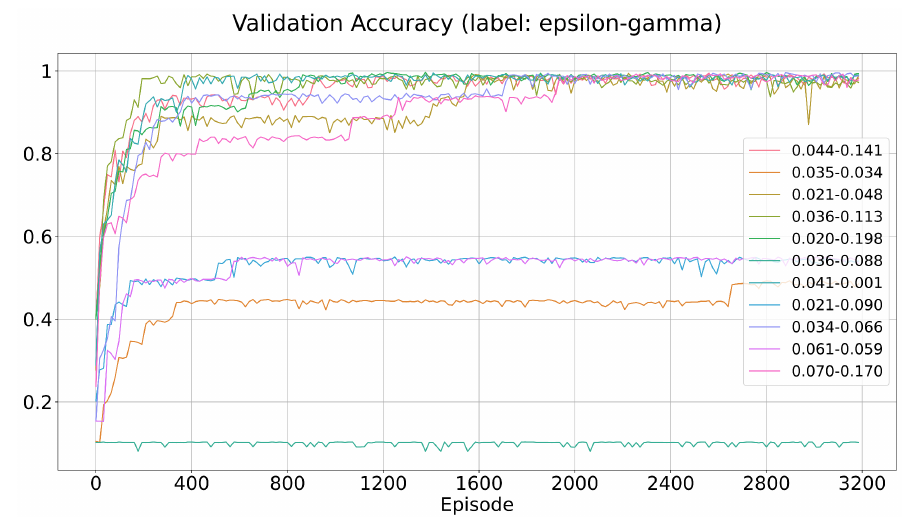
Figure 9. Performances on the validation set on DDoS2019 (Episode Reward). The averaged compu- tation time for training on each episode is 6.912 s.